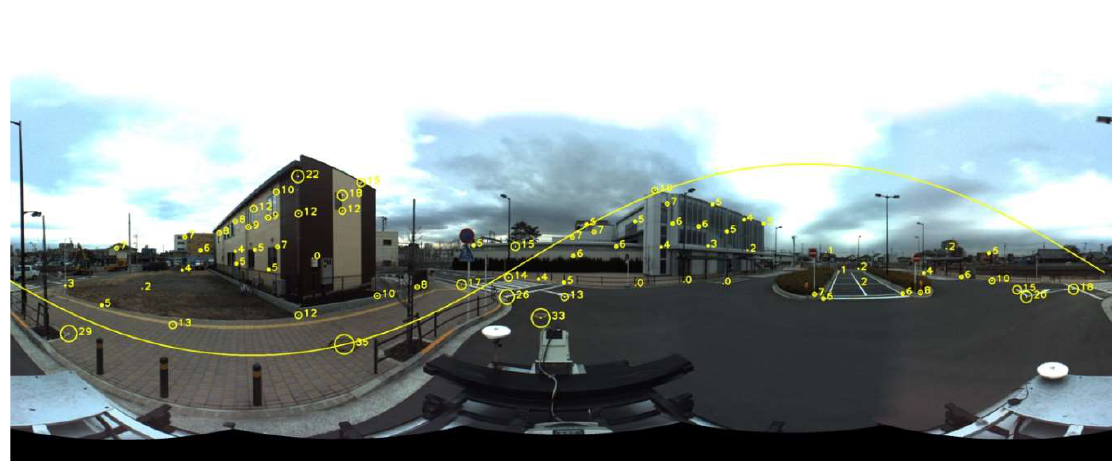
Figure 3. Epipolar of a panoramic image with sphere projection (yellow curve). Points in circles are selected for checking epipolar errors and bigger circles indicate larger errors (numbers beside the circles). Table 1. Checking epipolar bias in a panoramic image with known correspondent points.